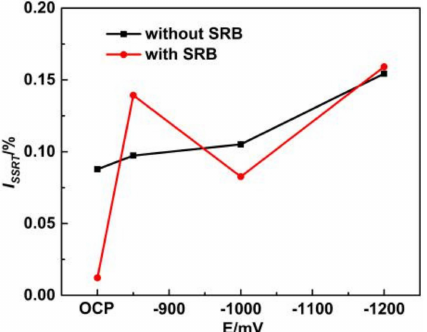
Figure 3. Broken line diagram of I SSRT of X80 steel under different conditions in high-pH